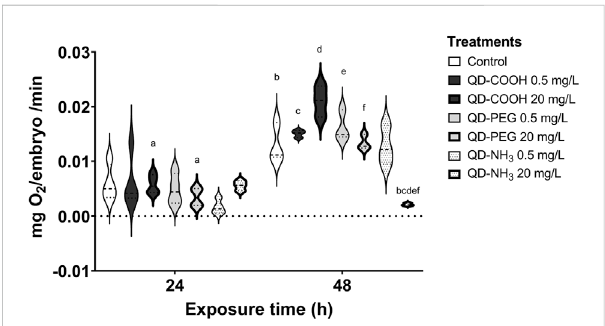
FIGURE 4 Respiration of Danio rerio embryos 24 hpf and 48 hpf. The graph represents the replicates and mean of each treatment. The same letters in superscript denotes a signi fi cant difference between treatments ( p < 0.05, T -tests).